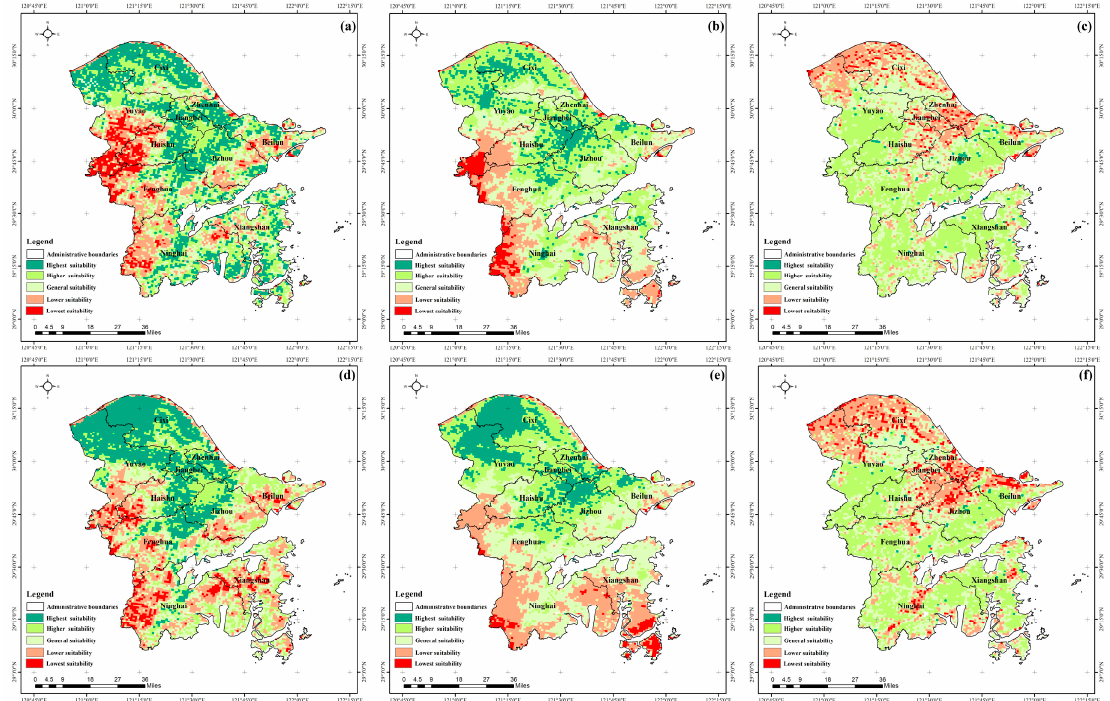
Figure 2. Suitability evaluation of PLES in Ningbo for ( a ) production space, ( b ) living space, and ( c ) ecological space in 2010; and ( d ) production space, ( e ) living space, and ( f ) ecological space in